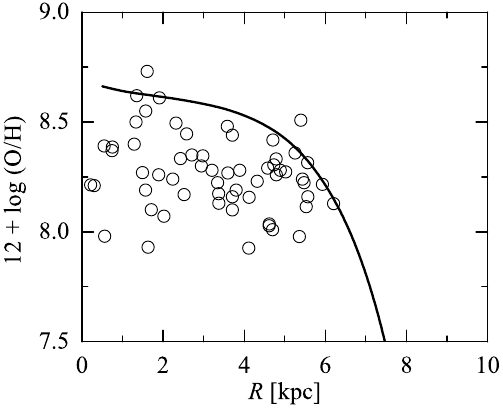
Fig. 5. The oxygen abundance model profile of gas in M 33. The solid line denotes the average of 30 models; the circles represent abundances of the H II zones (Rosolowsky & Simon